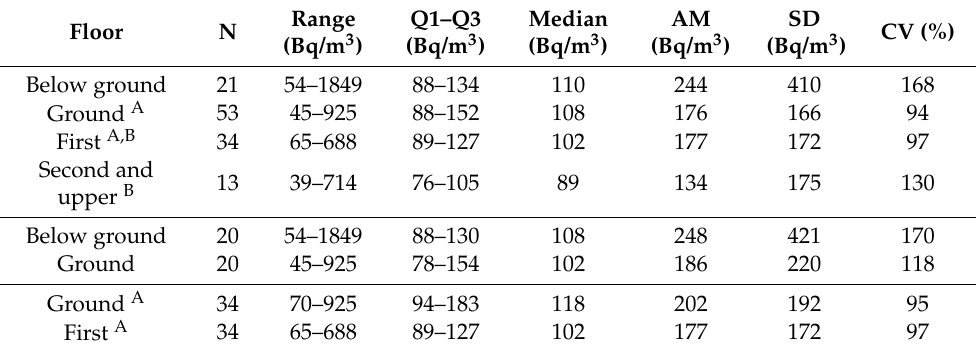
Table 3. Descriptive statistics 1 of annual radon activity concentrations per floor for all buildings (top), for 20 buildings which have both below ground floor and ground floor (central), for 34 buildings which have both ground floor and first floor (bottom). Floors share the same uppercase letter in apex if the corresponding distributions of annual radon activity concentration value have statistically significant differences ( p ≤ 0.05).